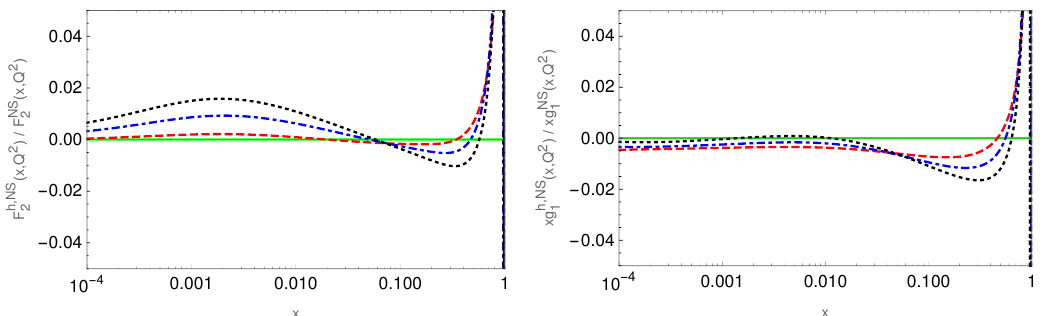
Figure 4: Left: The relative contribution of the heavy flavor contributions due to at N 3 LO; dashed lines: 100 GeV 2 ; c and b quarks to the structure function F NS 2 dashed-dotted lines: 1000 GeV 2 ; dotted lines: 10000 GeV 2 . Right: The same for the structure function x g NS at N 3 LO. From 1